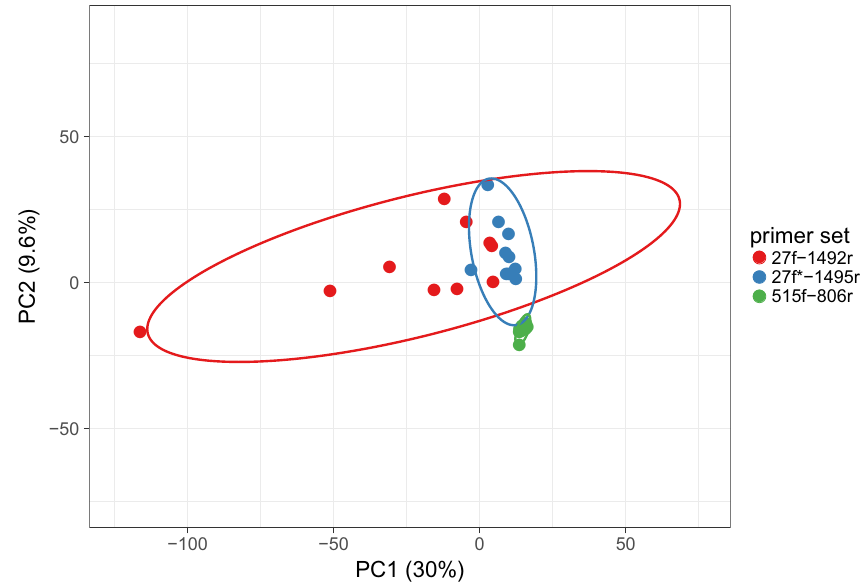
Figure 1. Comparative analysis of bacterial community at genus level of stool samples of children with ASD analysed by three different primer sets visualized by PCA. Analysis was performed at genus level using all detected (2731) bacterial genera. Set#1—515f/806r, set#2—27f/1492r, set#3—27f*/1495r. Unit variance scaling is applied to rows; SVD with imputation is used to calculate principal components. X and Y axis show principal component 1 and principal component 2 that explain 30.4% and 9.7% of the total variance, respectively. Prediction ellipses are such that with probability 0.95, a new observation from the same group will fall inside the ellipse. N = 29 data